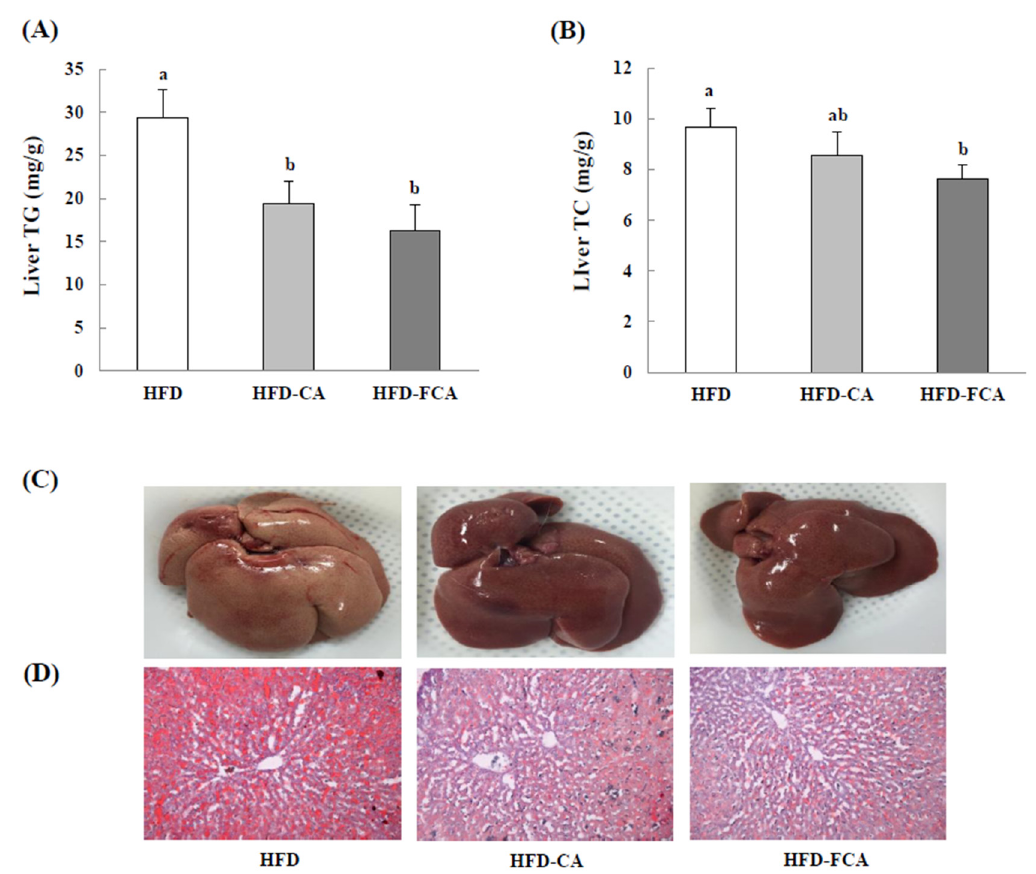
Figure 4. Hepatic triglyceride ( A ) and total cholesterol ( B ) levels, representative anatomical views ( C ), and histopathological analysis ( D ) in rats fed experimental diets for 8 weeks. All sections were stained with Oil Red O, ×100. Values are mean ± SE ( n = 8 rats per group). a,b; Bars with different letters are significantly different at p < 0.05 by Tukey’s test. Diet groups; HFD, high fat diet group: HFD-CA, HFD + cabbage-apple juice administration group: HFD-FCA, HFD + fermented cabbage-apple juice administration group.